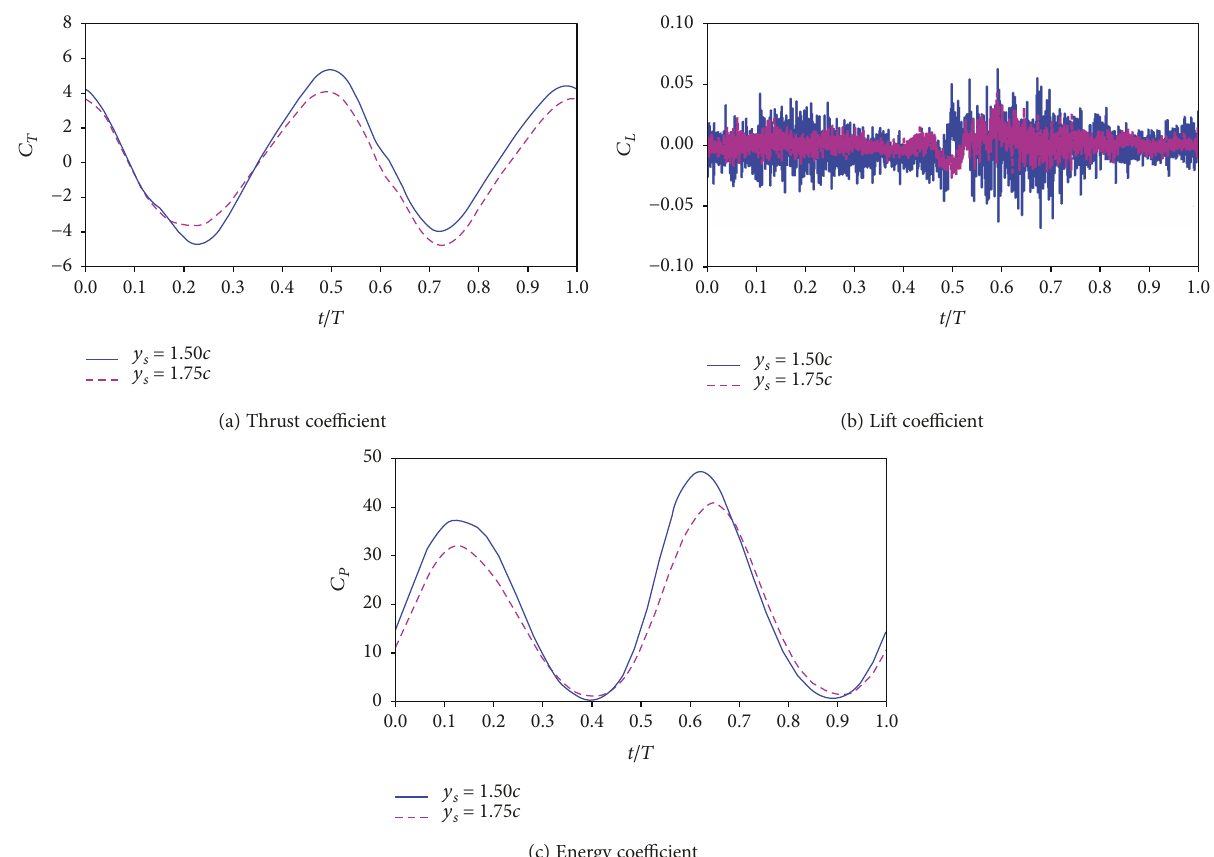
Figure 11: Time variation of the thrust coe ffi cient, lift coe ffi cient, and energy coe ffi cient of the biplane counter- fl apping wing with y and 1 75 c , ϕ = 60 °